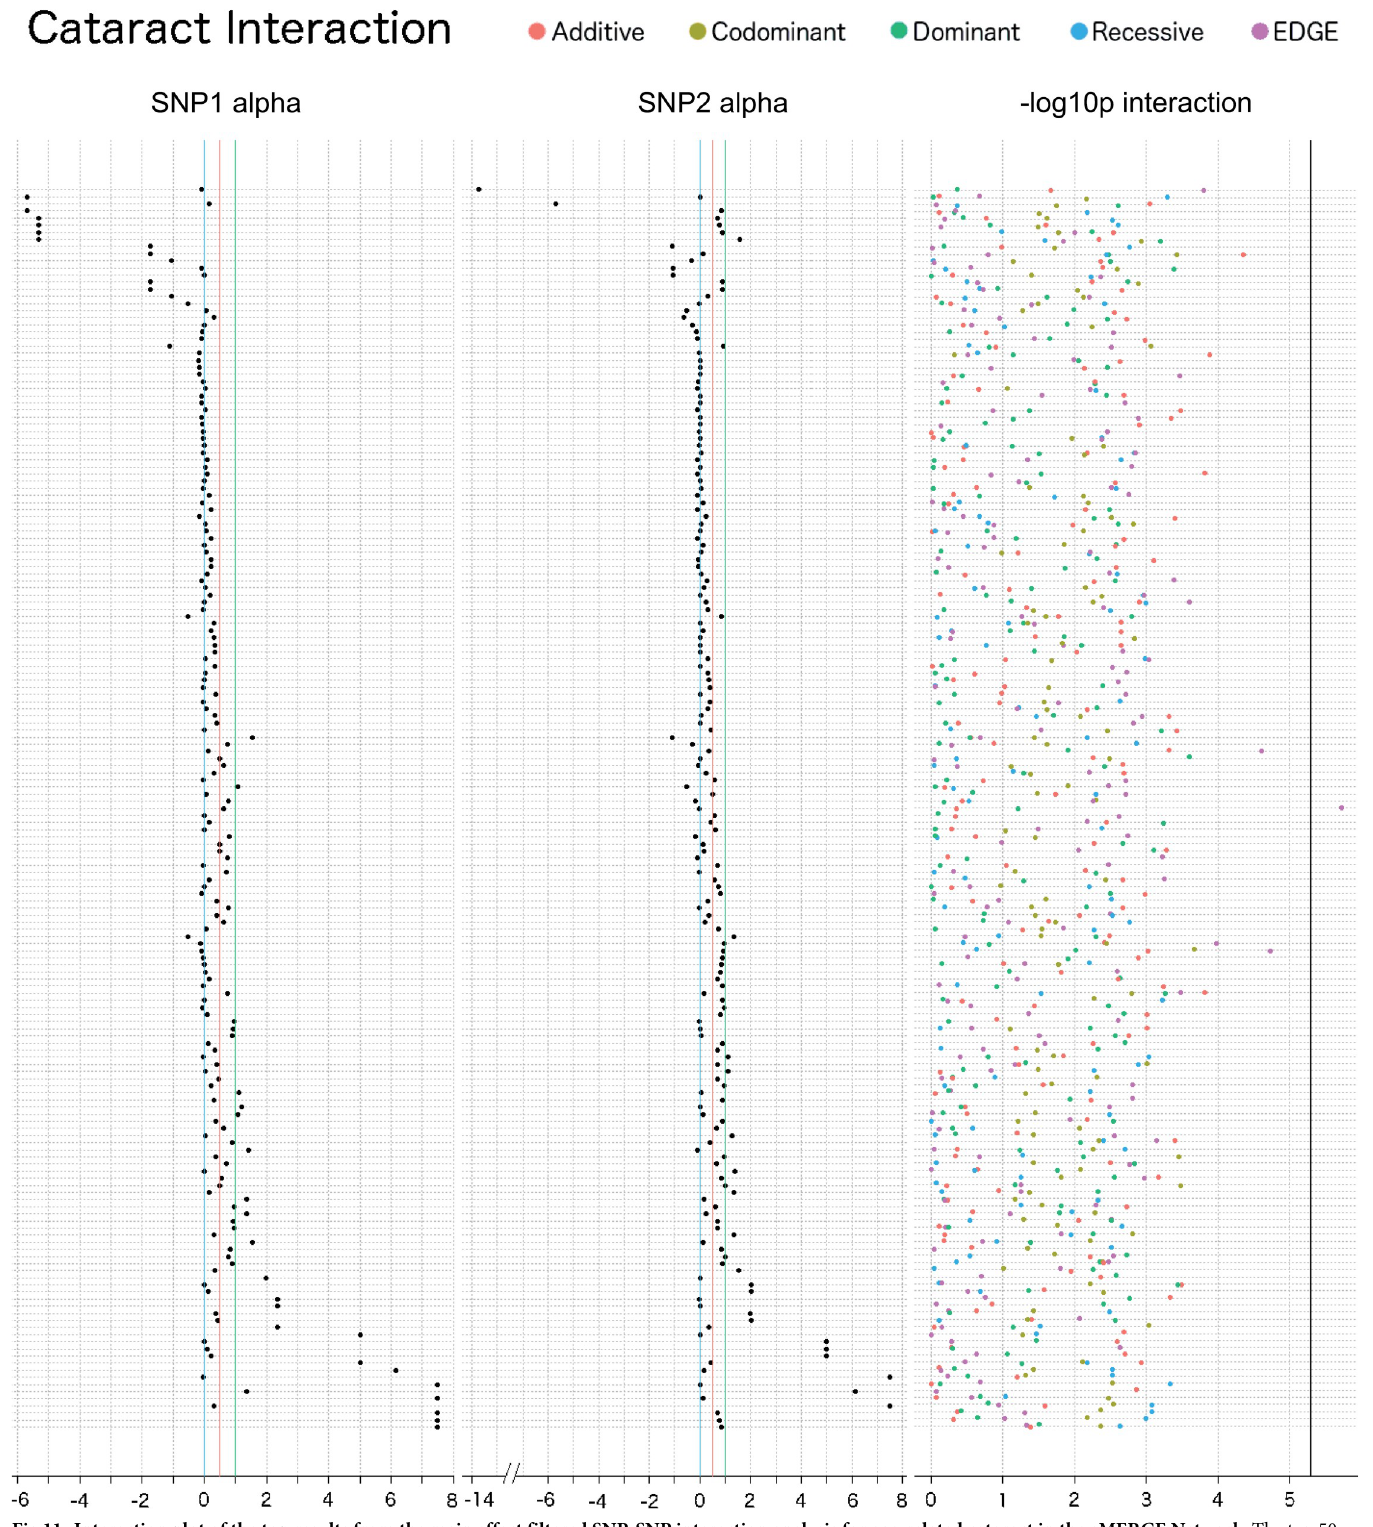
Fig 11. Interaction plot of the top results from the main effect filtered SNP-SNP interaction analysis for age-related cataract in the eMERGE Network. The top 50 SNPs from the multi-encoding cataract GWAS in the eMERGE Network were considered for a pairwise SNP-SNP interaction analysis using additive (red), dominant (green), recessive (blue), codominant (yellow) and EDGE (purple) encoding methods. Track one displays the EDGE-derived heterozygous alpha value of SNP 1, track